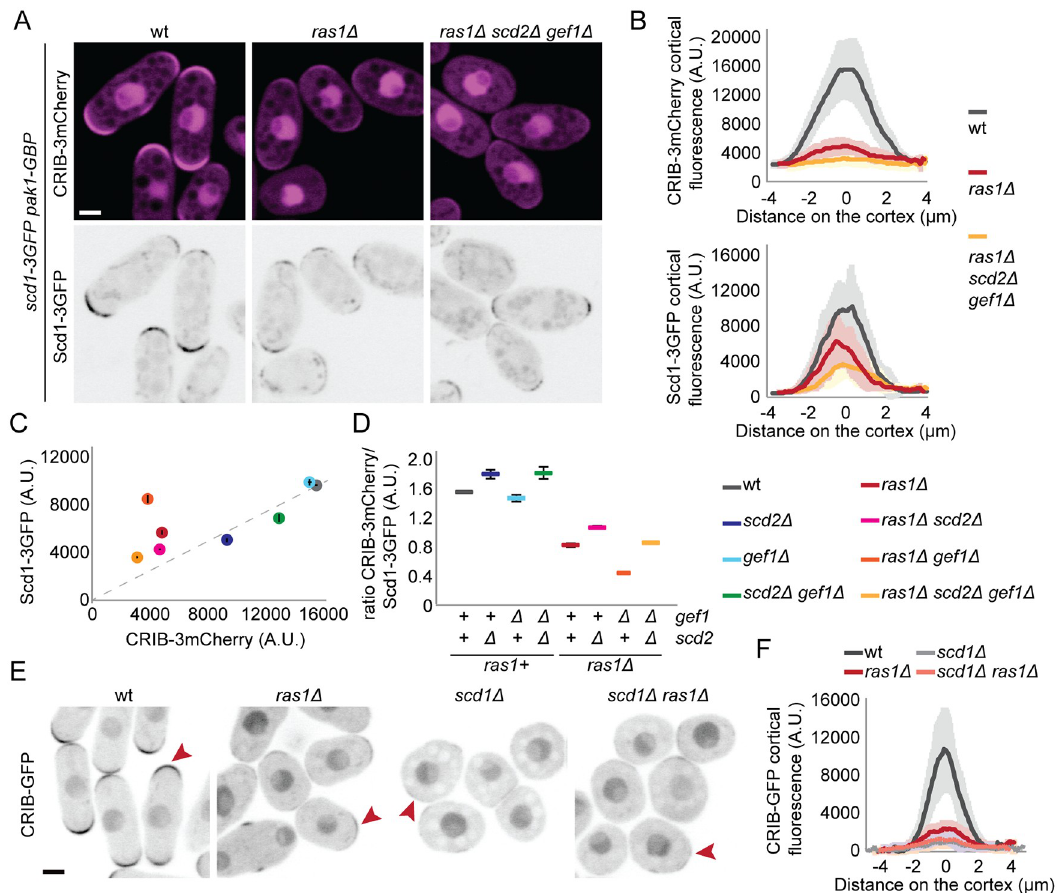
Fig 7. Ras1 promotes the activation of the Cdc42 GEF Scd1. (A) Localization of Scd1-3GFP (B/W inverted images) and CRIB- 3mCherry (magenta) in wt, ras1 Δ and scd2 Δ ras1 Δ gef1 Δ cells expressing the scd1-pak1 bridge . (B) Cortical tip profiles of CRIB- 3mCherry (top) and Scd1-3GFP (bottom) fluorescence in strains as in (A); n = 30 cells. (C) Plot of CRIB-3mCherry versus Scd1- 3GFP fluorescence at the cell tip in strains of indicated genotypes expressing the scd1-pak1 bridge and CRIB-3mCherry as in (A) and S9A Fig. (D) Ratio of CRIB-3mCherry and Scd1-3GFP fluorescence at the cell tip of strains as in (C). (E) Localization of CRIB-GFP in wt, ras1 Δ , scd1 Δ , and ras1 Δ scd1 Δ cells (B/W inverted images). (F) Cortical tip profiles of CRIB-GFP fluorescence in strains as in (E); n = 25 cells. In (B) and (F), thick line = average; shaded area = standard deviation. Bars = 2 μ m. All underlying numerical values are available in S7 Data. A.U., arbitrary units; B/W, black and white; wt, wild type.